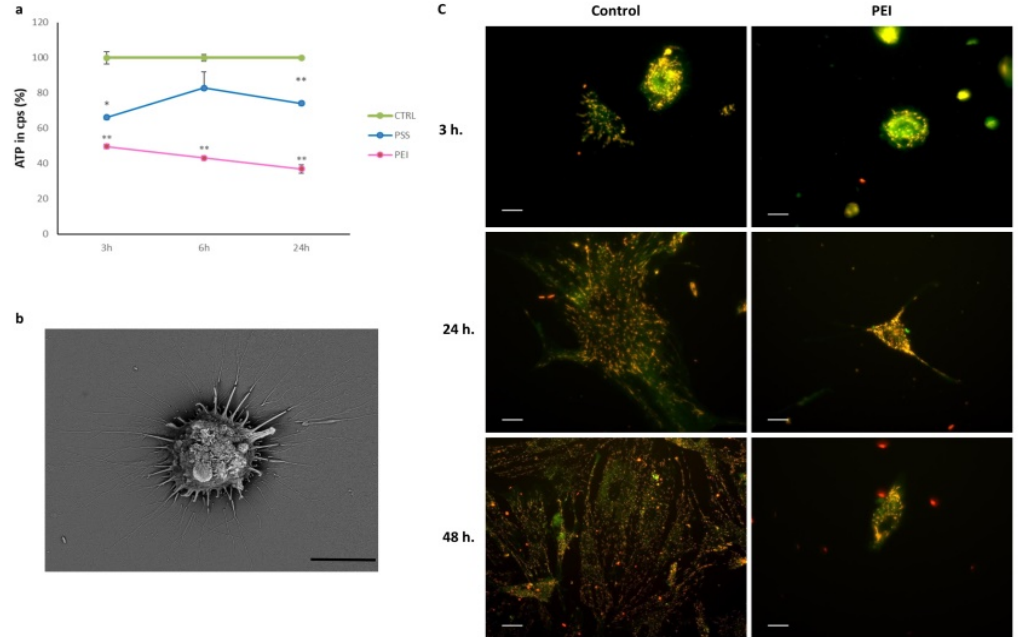
Figure 9. Effect of the PEI layer on ( a ) ATP content and ( b ) ultrastructure and mitochondrial trans- membrane potential ( ∆Ψ ) on MSCs. ( a ) Values (cps) are derived from the average of three experiments and expressed as percentages referring to the control; * p < 0.05 and ** p < 0.01 versus CTRL (one-way ANOVA). ( b ) Scanning electron micrography; scale bar: 10 μ m. ( c ) ΔΨ analyzed with JC1 red represents J-aggregates, i.e., active mitochondria; scale bar: 10 μ m.